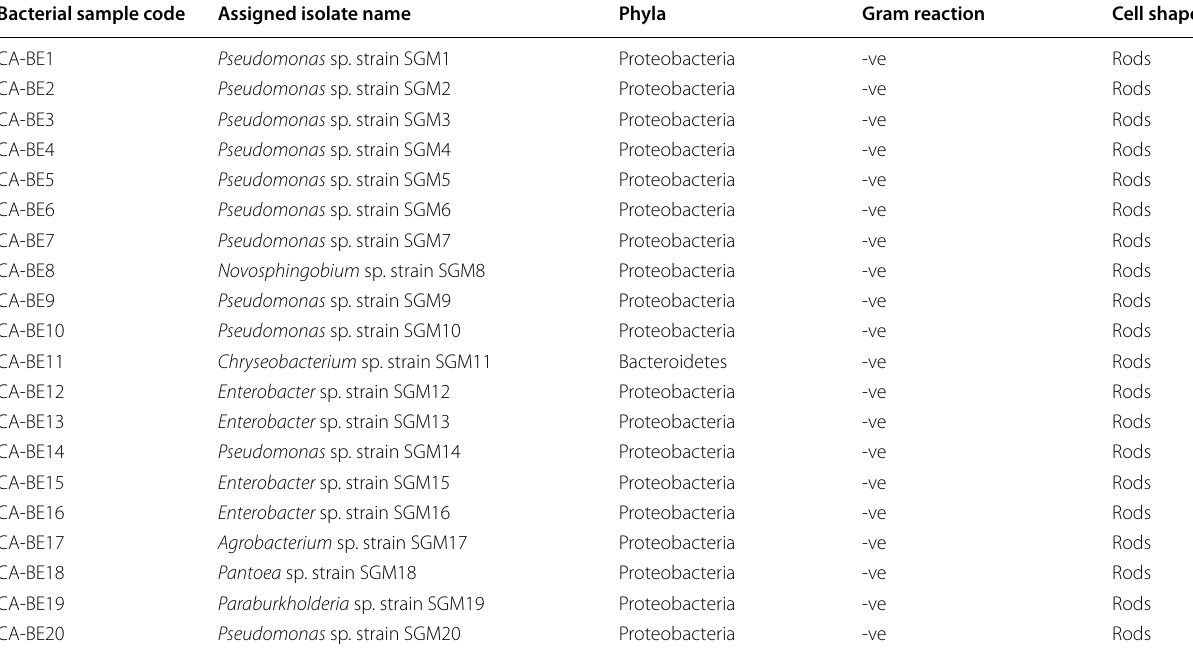
*Gram reaction: -ve , gram negative